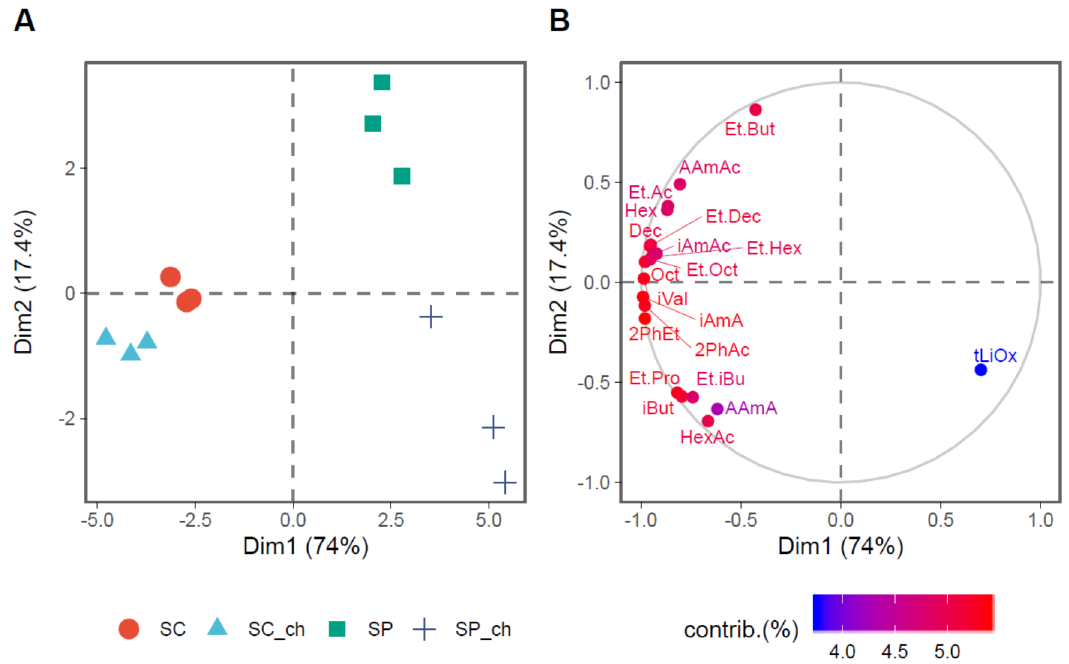
Figure 3. Principal component analysis of the microbial metabolic contribution to the aroma of the wines. ( A ) The plot of the fermentation treatments in the two principal dimensions (Dim1 and Dim2), which indicates 91.7% of the variance in the data. ( B ) The plot of the first 15 variables with the highest contribution on the explained variance between treatments in the two dimensions is presented in a continuous scale of colors that show the lowest contribution (blue) to the highest (red). Abbreviations: Ethyl acetate (Et.Ac), Isobutanol (iBut), Ethyl propionate (Et.Pro), Isoamyl alcohol (iAmA), Active amyl alcohol (AAmA), Ethyl isobutyrate (Et.iBu), Ethyl butyrate (Et.But), Isovaleric acid (iVal), Isoamyl acetate (iAmAc), Active amyl acetate (AAmAc), Hexanoic acid (Hex), Ethyl hexanoate (Et.Hex), Hexyl acetate (HexAc), trans-Linalool oxide (tLiOx), 2-Phenylethanol (2PhEt), Octanoic acid (Oct), Ethyl octanoate (Et.Oct), 2-Phenylethyl acetate (2PhAc), Decanoic acid (Dec), and Ethyl decanoate (Et.Dec).